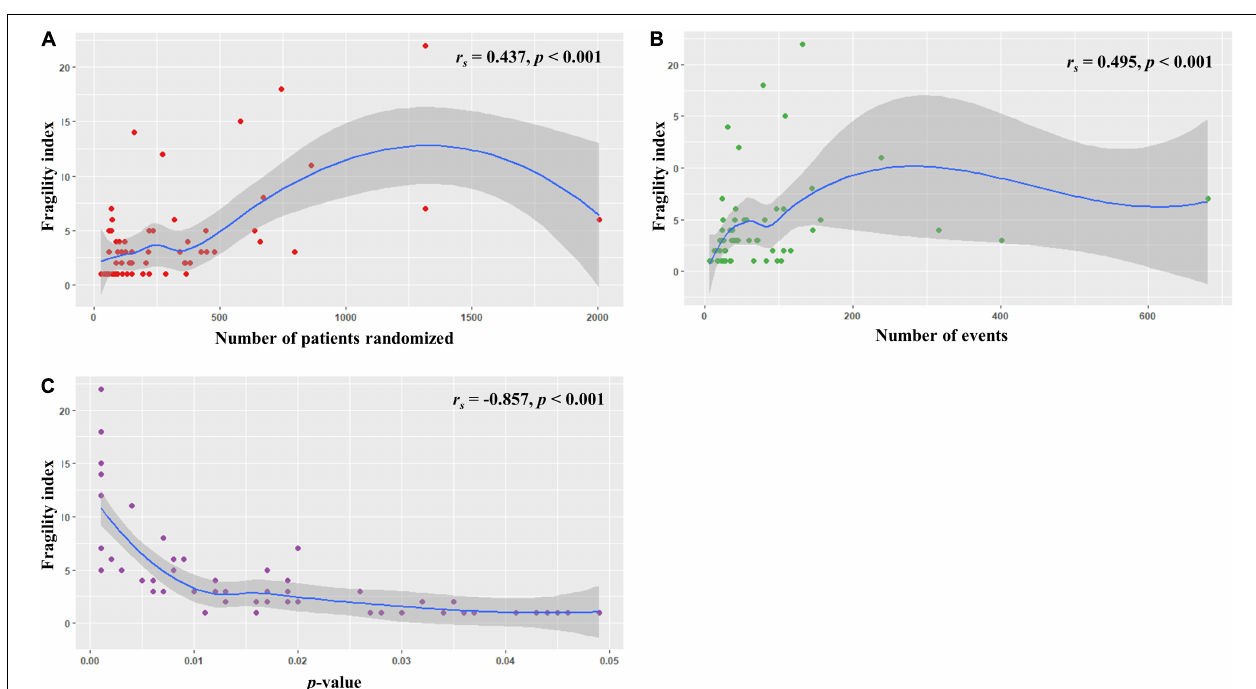
FIGURE 2 | Relationships between the fragility index and (A) sample size, (B) total number of events, and (C) p value.